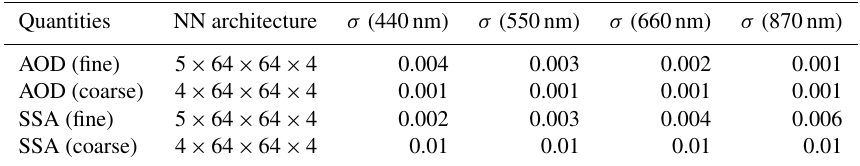
Table A1. The accuracy of the NN for the corresponding quantities in terms of the RMSE ( σ ) between the NN-predicted values and the truth values from the Lorenz–Mie